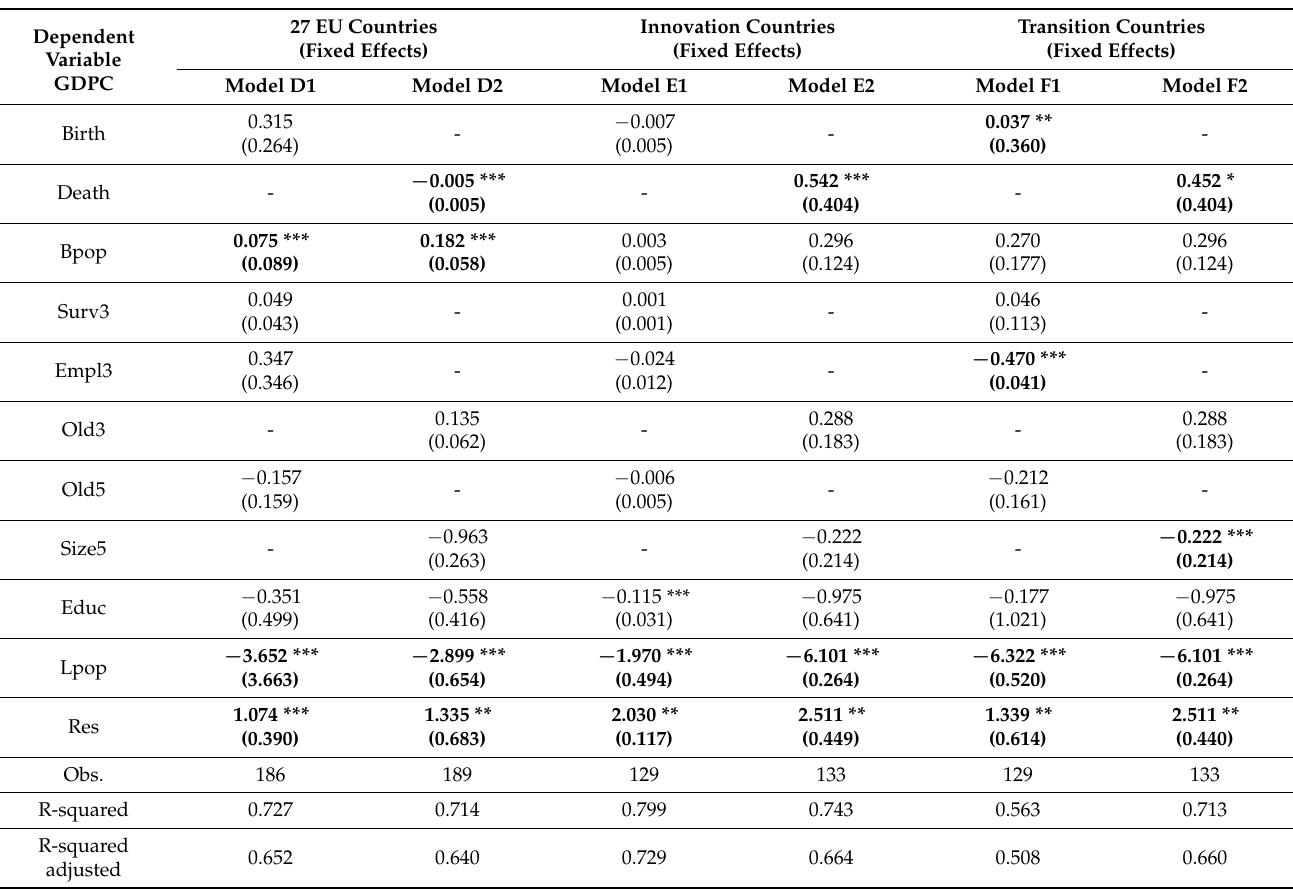
Table 6. Effects of entrepreneurial performance on economic